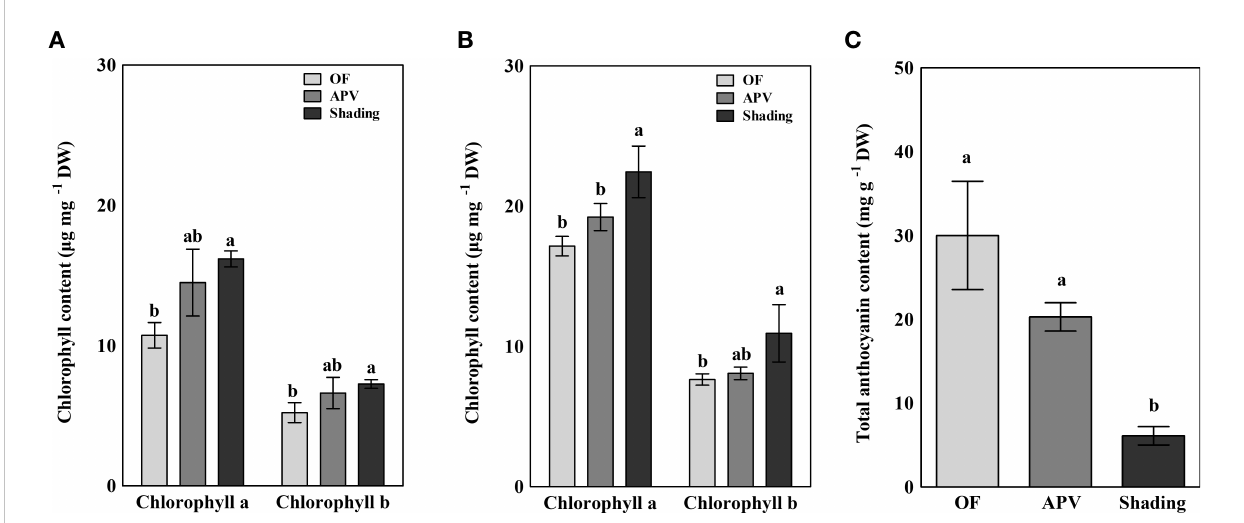
FIGURE 7 Chlorophyll a and b contents extracted from the buds of 2022 spring ‘ Earlyyou ’ (A) and ‘ Youil2ho ’ (B) . Anthocyanin abundance was measured only in the ‘ Earlyyou ’ cultivar (C) . The content of total anthocyanin was calculated as cyanidin-3-glucoside equivalent. Lowercase letters indicate signi fi cant differences among treatments within the same cultivar and year by HSD Tukey ’ s test (p <